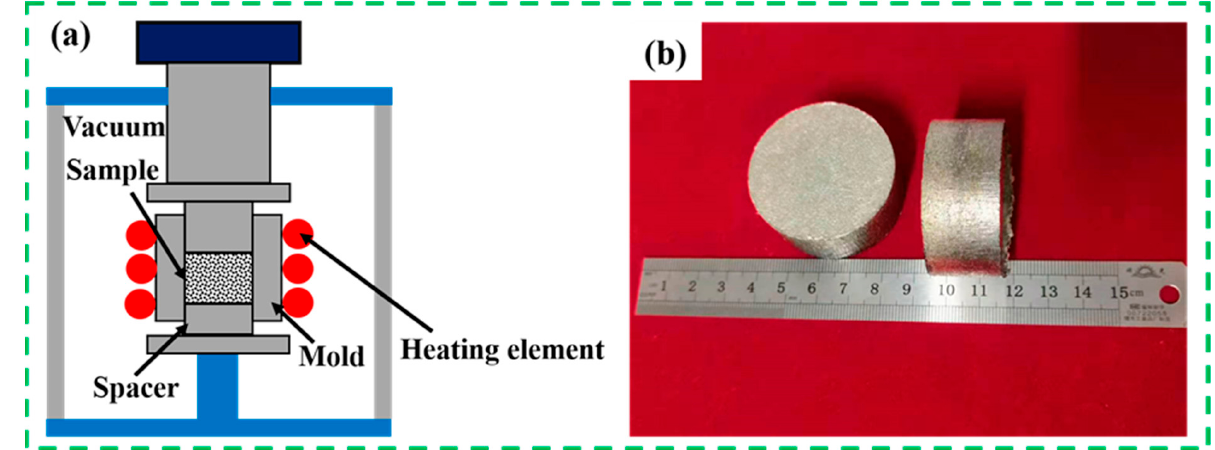
Figure 2. Schematic illustration of vacuum hot ‐ press sintering ( a ) and image of sintered AZ31 ‐ V P composites ( b ). After sintering process, the theoretical density of samples was calculated by using the rule of mixture, which was illustrated in Equation (1) [7] where ρ t is the sintered theoretical density. ρ r and ρ m represent the theoretical densities of V P and Mg matrix. V r and V m are the volume fractions of V P and Mg matrix.